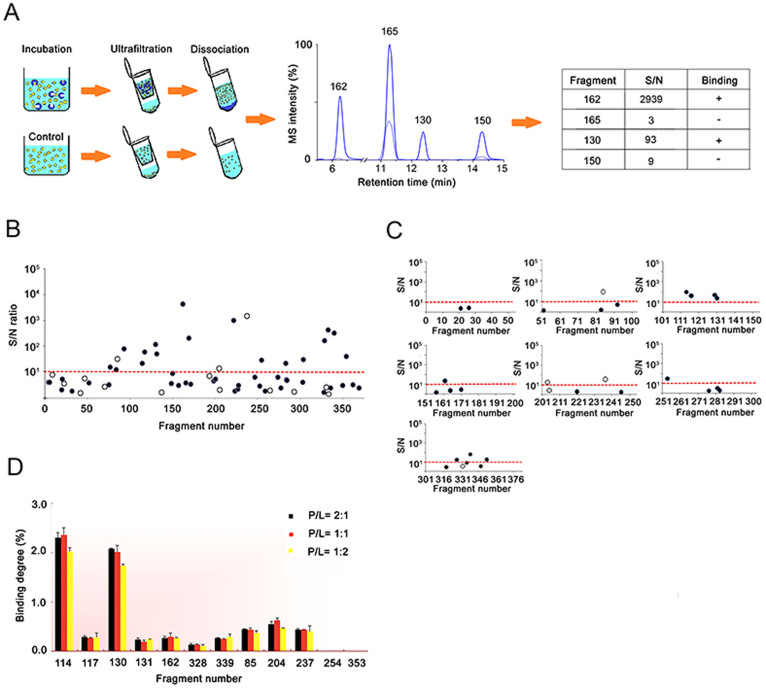
Fragment library screening based on the ligand-observed LC/MS approach.(A) Scheme of the MS-based fragment screening workflow. The protein is incubated with a mixture of the fragment library, ligand-bound complexes are purified by ultrafiltration and the dissociated ligands are identified and quantified by LC/MS. Positive fragment binding is indicated by its S/N ratio > 10. (B) Results of the primary screen of a 384-member fragment library in a single run. Solid and open circles designate data points acquired in the positive and negative modes of MS analysis respectively. Circles above the threshold line denote positive hits. S/N ratios are averages of experimental duplicates. (C) Results from the secondary screen of 7 subdivided fragment cocktails, each consisting of 50 or 86 members. A total of 12 hits were identified in this run. S/N ratios are averages of experimental duplicates. (D) Binding degrees of individual fragments measured from the 12-hit mixture at different protein/ligand ratios (P/L) while the protein concentration was held constant in incubation. Ten fragments were validated to bind to NS5B and their binding degrees indicate a relative order of binding affinity. Error bars denote s.d. from experimental duplicates.